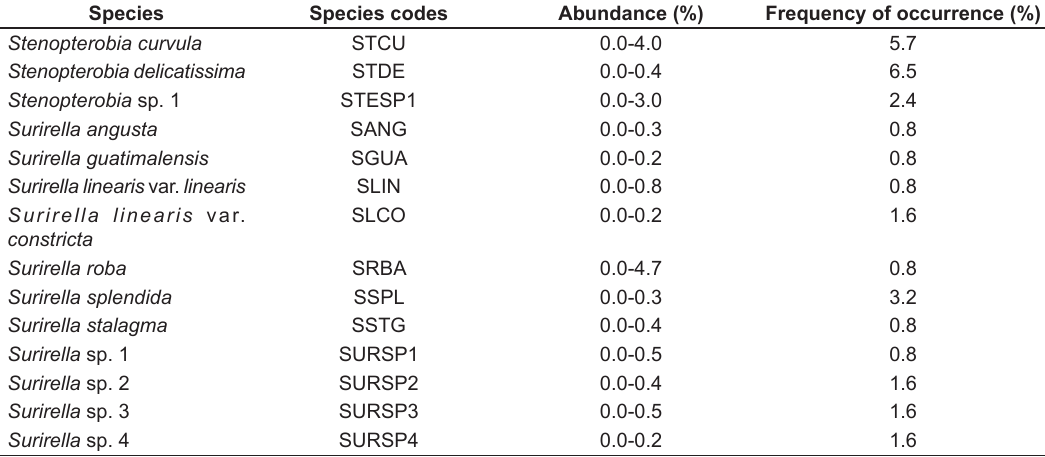
Table 2. Surirellales relative abundance and frequency of occurrence in samples (n = 123 sites). Species codes according to OMNIDIA (except for material at generic